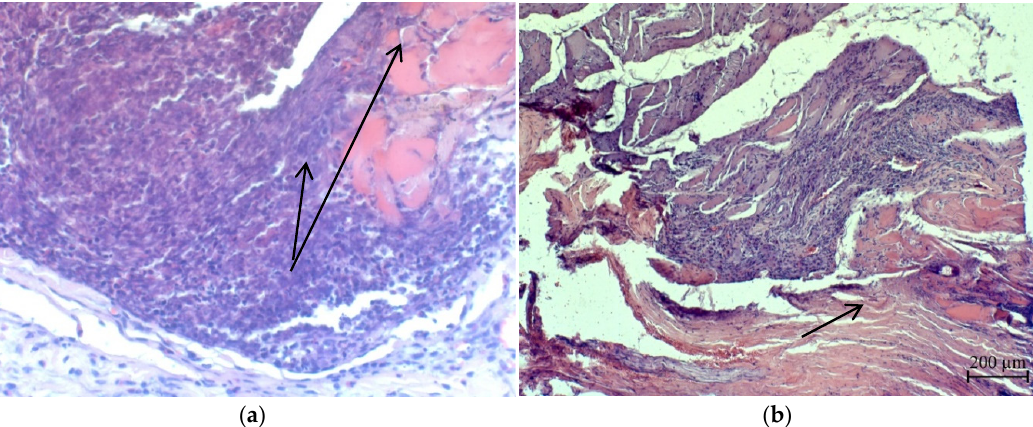
Figure 22. Accumulation of cellular infiltrate under the scab: focal necrosis of muscle fibers (indicated by the arrow): ( a )—the first group and ( b )—the second group. Necrotized skeletal muscles are slightly thickened, streakless and homogeneous, rep ‐ resenting a homogeneous oxyphilic mass. In deeper lying tissues from extensive cellular infiltration at a depth of 400.0–500.0 μ m, cellular infiltrates consisting mainly of lympho ‐ blood vessels in the form of couplings (Figure 23). Changes in blood vessels are character ‐ istic of arterial hyperemia.